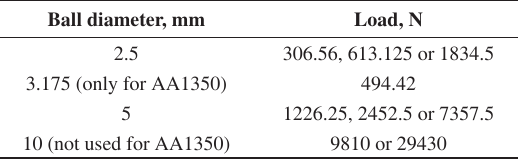
Table 1. Load ( L ) and ball diameter ( D ) combinations used in the spherical indentation tests. Ball diameter, mm